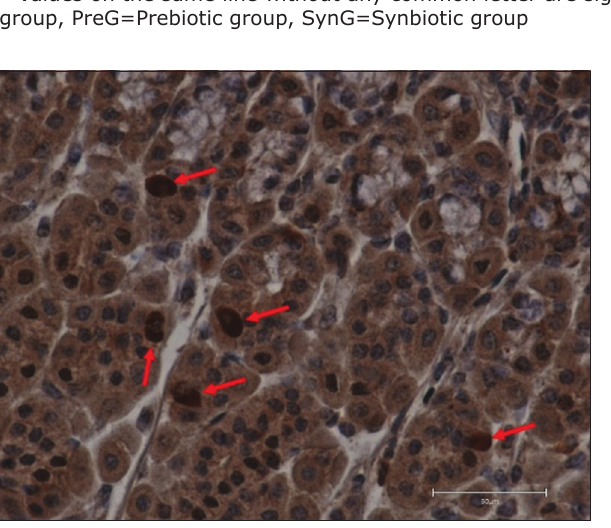
Figure-3: Ghrelin immunoreactive + cells (arrows) in a 13-week-old calf from the control group in the abomasum pars fundalis (400×, DAB + hematoxylin, scale bar 50 µ m).